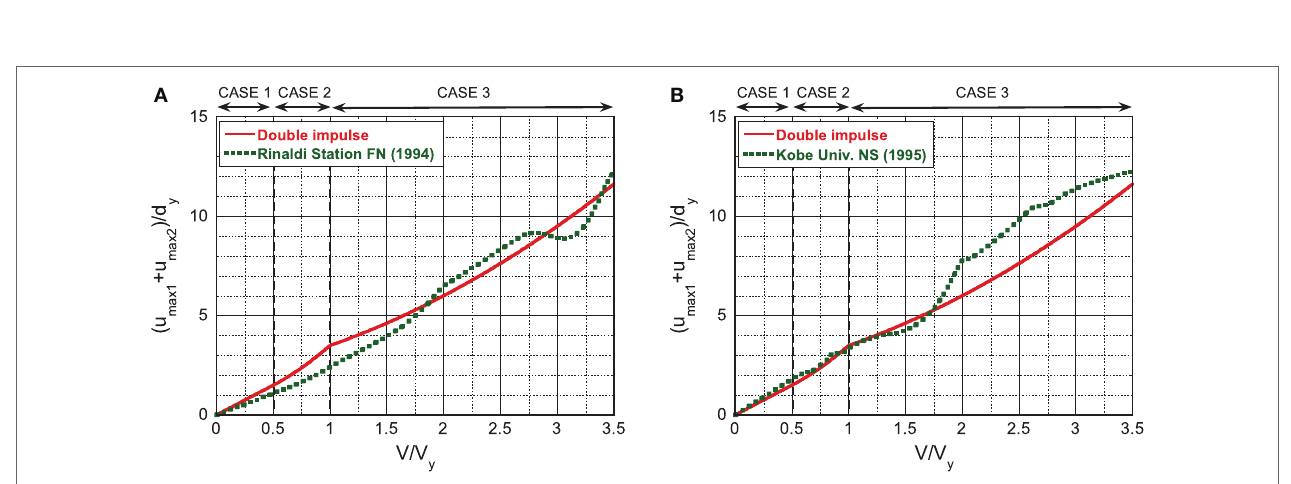
FigUre 15 | Maximum amplitude of deformation for the recorded ground motions and the proposed one: (a) rinaldi station fault-normal component and (B) Kobe University ns component.